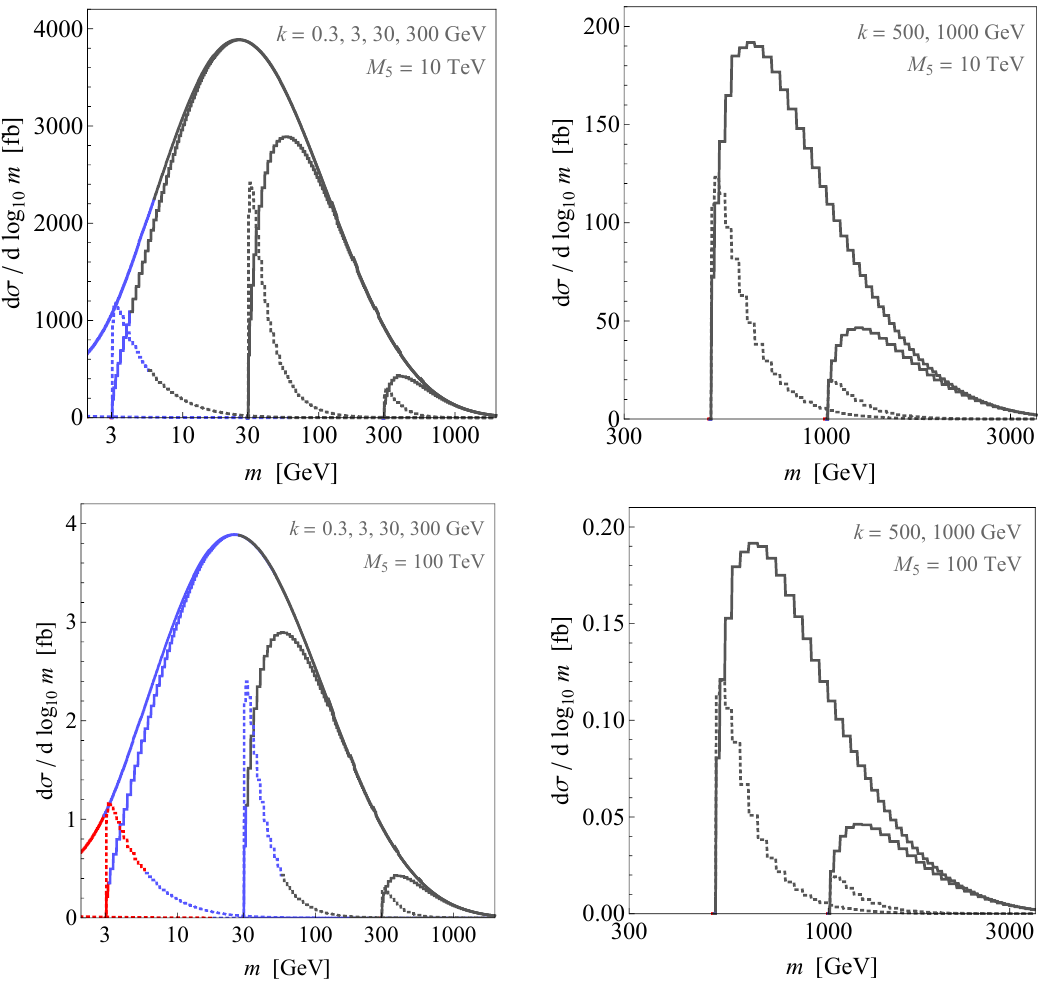
Figure 9 . The KK graviton (solid) and KK scalar (dashed, multiplied by a factor of 500) LHC p production cross sections at s = 13 TeV for M 5 = 10 TeV (top) and 100 TeV (bottom), k = 0 : 3, 3, 30 and 300 GeV (left) and 500 and 1000 GeV (right). The KK mode lifetimes are color-coded: decays close to the interaction vertex ( c(cid:28) < 1 mm) are in black, displaced decays ( c(cid:28) < 10 m) are in blue, and the detector-stable regime is in red. For the KK scalars, the results are presented for the case of rigid boundary conditions and (cid:24) =